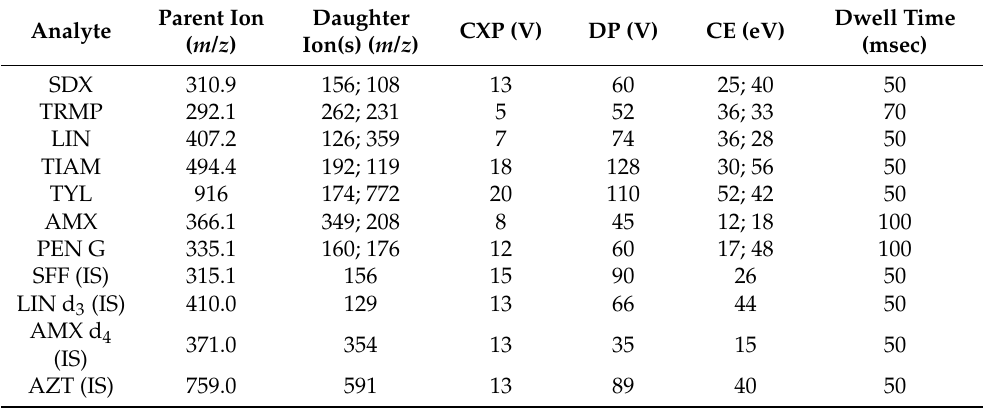
Table 4. MS/MS parameters and summary of the MRM monitored for presented